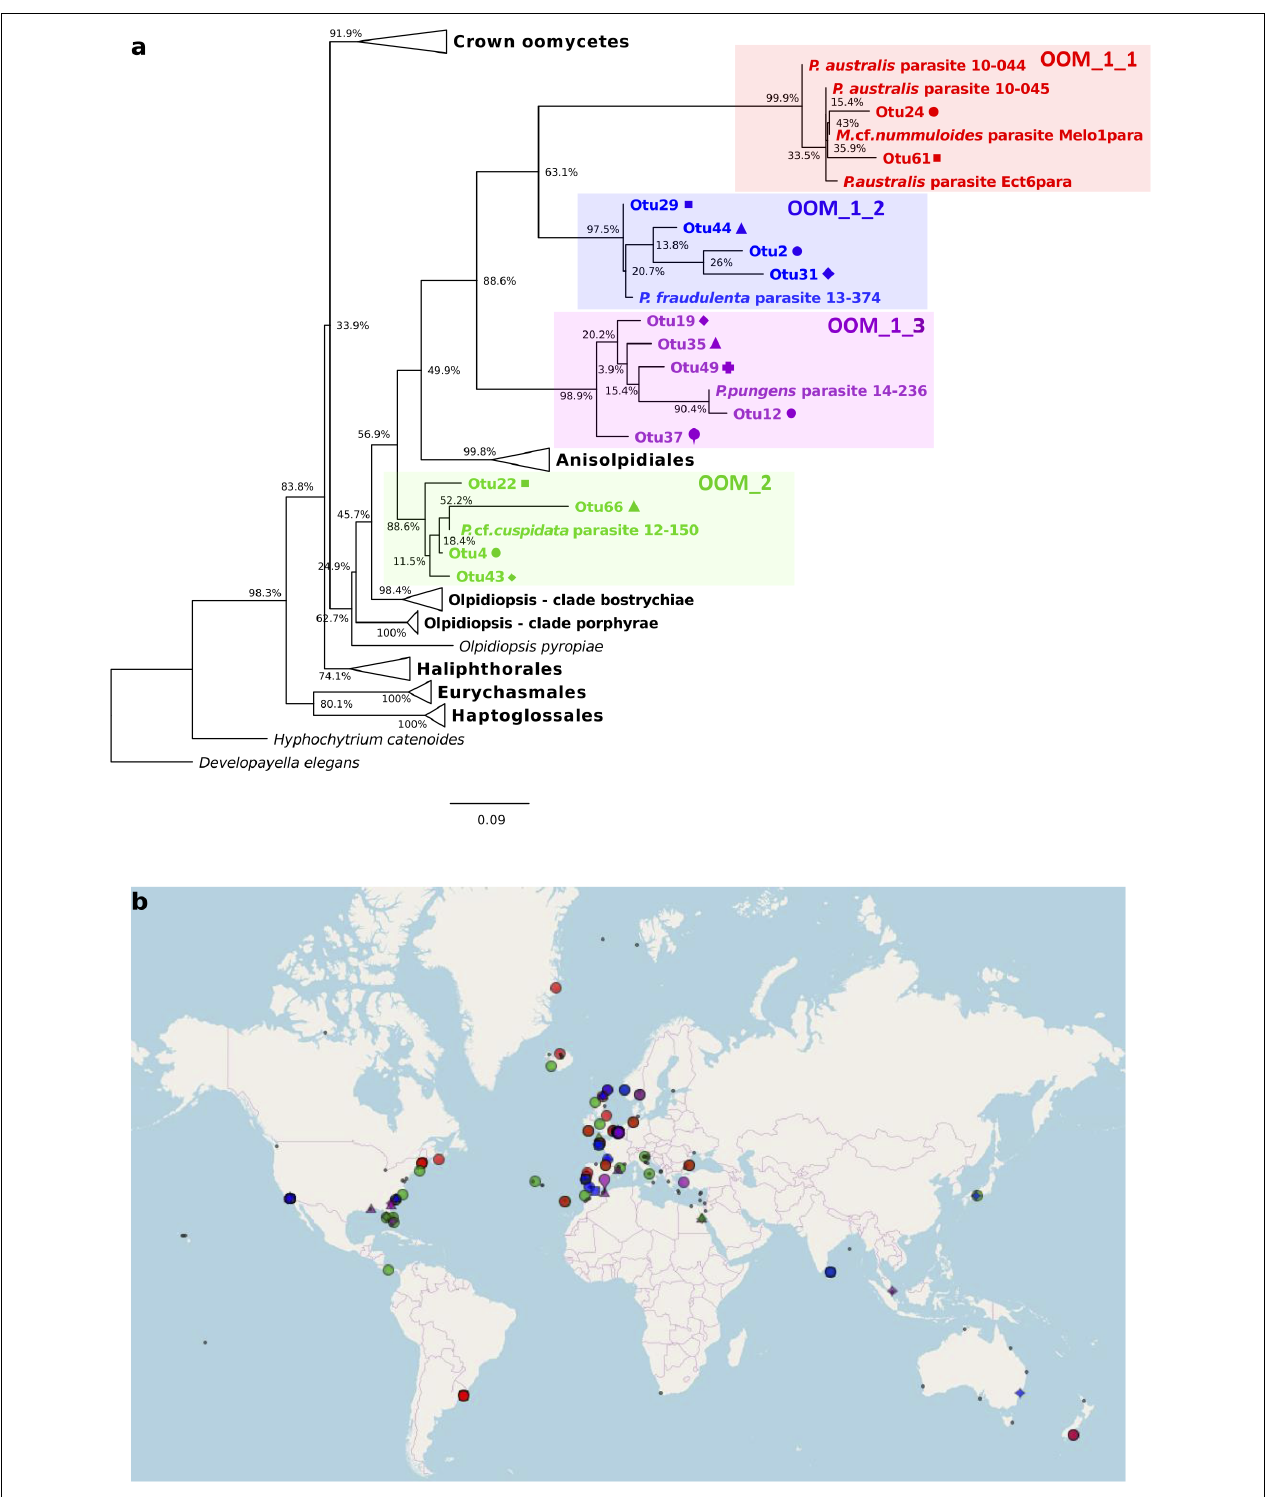
FIGURE 6 | Diversity and distribution of OOM_1 and OOM_2 related OTUs based on public SRA marine barcoding datasets. The colour code identifies each one of the four new clades of diatom parasitoids OOM_1_1 (red), OOM_1_2 (blue), OOM_1_3 (purple) and OOM_2 (green). (a) Maximum Likelihood tree of 15 18S rDNA V4 OTUs retrieved by the MOULINETTE Pipeline. Refer to the alignment in Supplementary Data Sheet S4 . (b) Global distribution of each detected OTU based on GPS coordinates of matching SRA runs. Within-clade symbols are attributed to different OTUs.